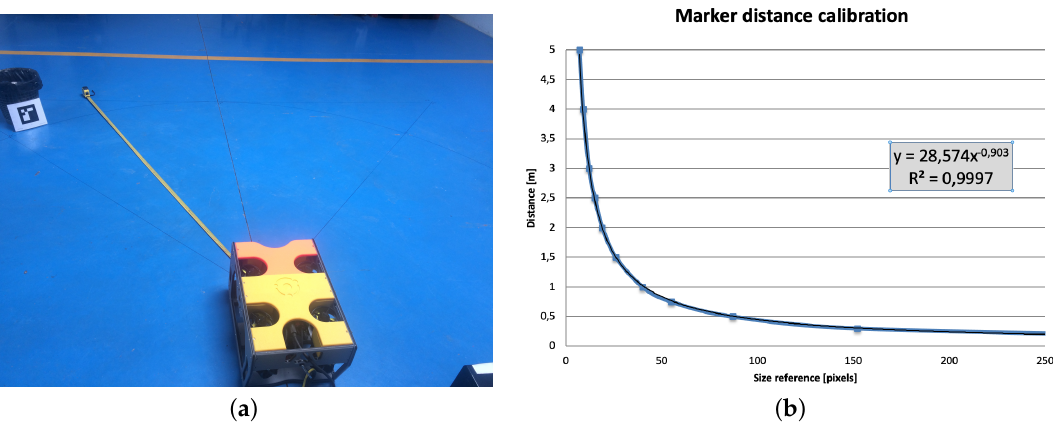
Figure 3. ( a ) Distance calibration of Aruco markers and ( b ) the distance calibration interpolation function.